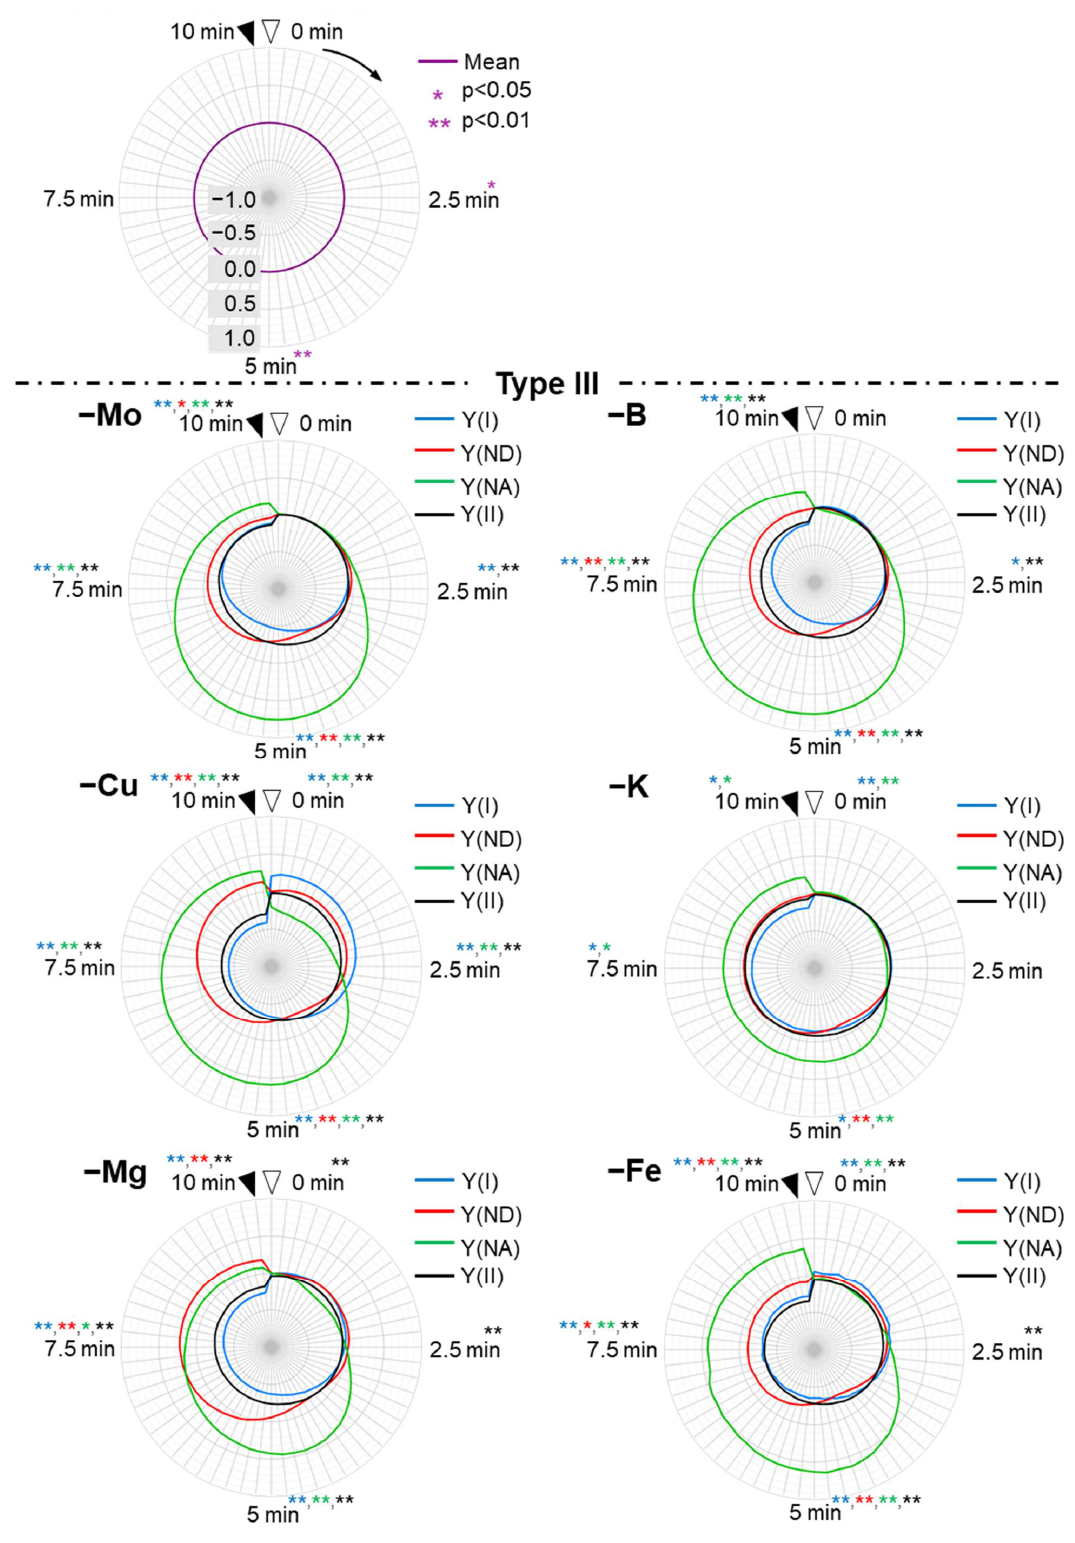
Figure 4. Effects of nutrient-deficiency treatments on the photosynthesis parameters of PSI and PSII in the intact leaves of sunflower plants ( Helianthus annuus ). Data were calculated from Figure 3. The parameters [Y(I), blue; Y(ND), red; Y(NA), green; Y(II), black] were the difference values between the control and the nutrient deficiency (difference original plots). Nutrient- deficiency treatments are as follows: Type-I: nitrogen deficiency (–N); phosphate deficiency (–P). Type-II: calcium deficiency (–Ca); zinc deficiency (–Zn); sulfur deficiency (–S); manganese deficiency. Type-III: molybdenum deficiency (–Mo); cupper deficiency (–Cu); magnesium deficiency (–Mg); boron deficiency (–B); potassium deficiency (–K); iron deficiency (–Fe). Data presented are